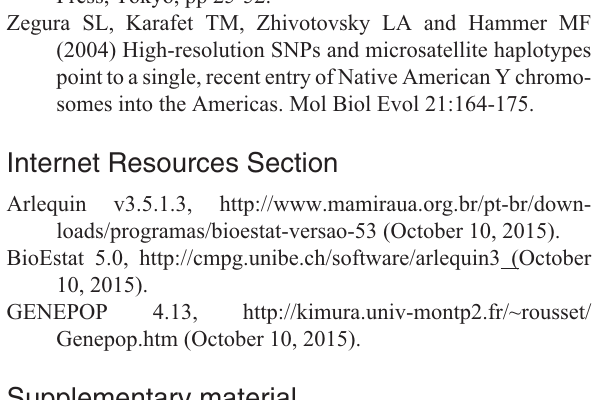
Table S1 - Genetic distance (F ST ) among the seven Chilean com- munities by means of mtDNA haplogroups. Table S2 - Genetic distance (FST) among the seven Chilean com- munities using NRY markers. Table S3 - AMOVA comparison among the three studied